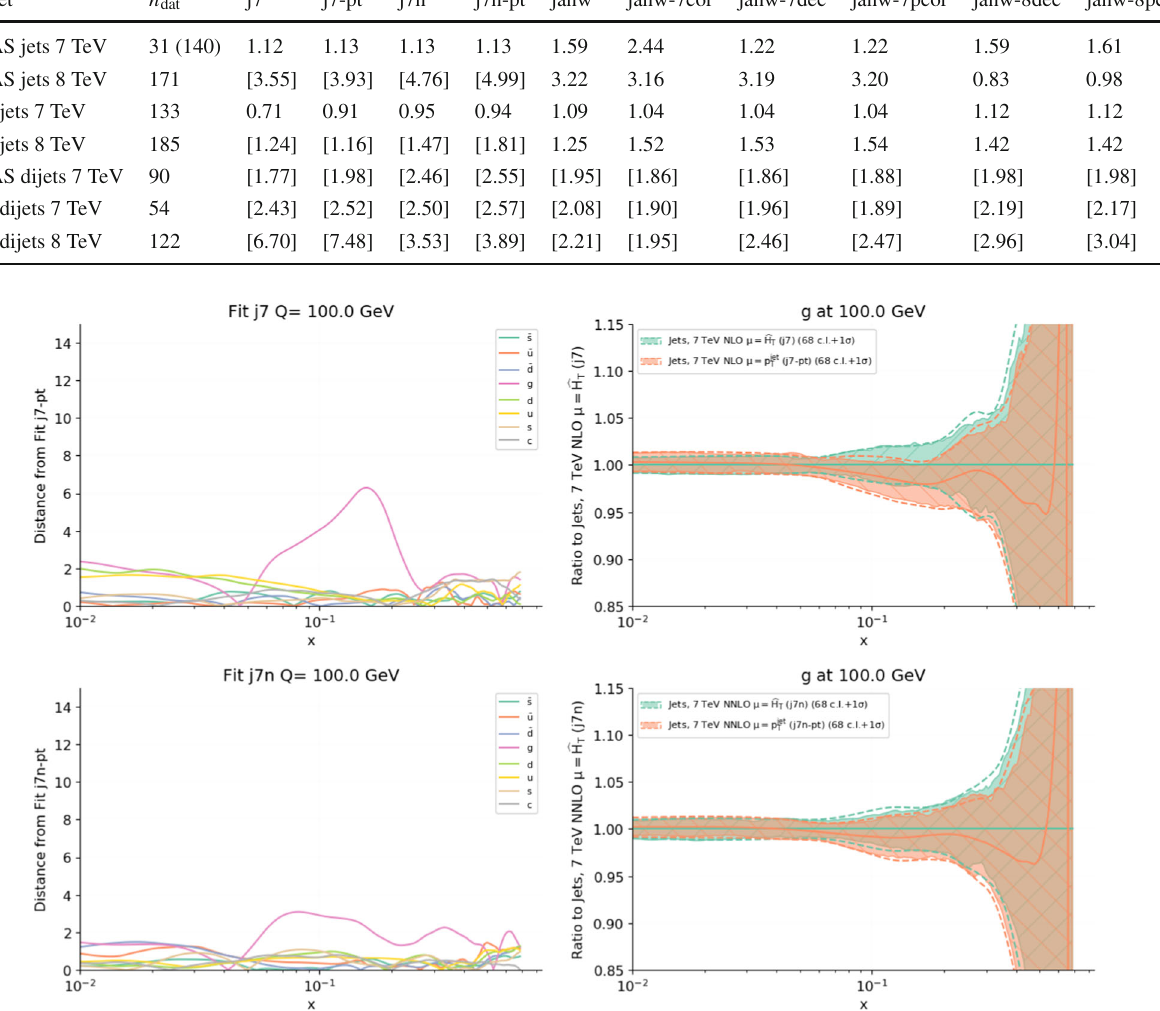
Fig. 9 Same as Fig. 6, but now comparing fits to the 7 TeV data with the choices of central renormalization and factorization scale scale μ = (cid:2) H T (as shown in Fig. 8, top) and μ = p jet at NLO (fits #j7 and #j7-pt) and NNLO (fits #j7n and #j7n-pt). The gluon is shown as ratio to the fits with T μ =